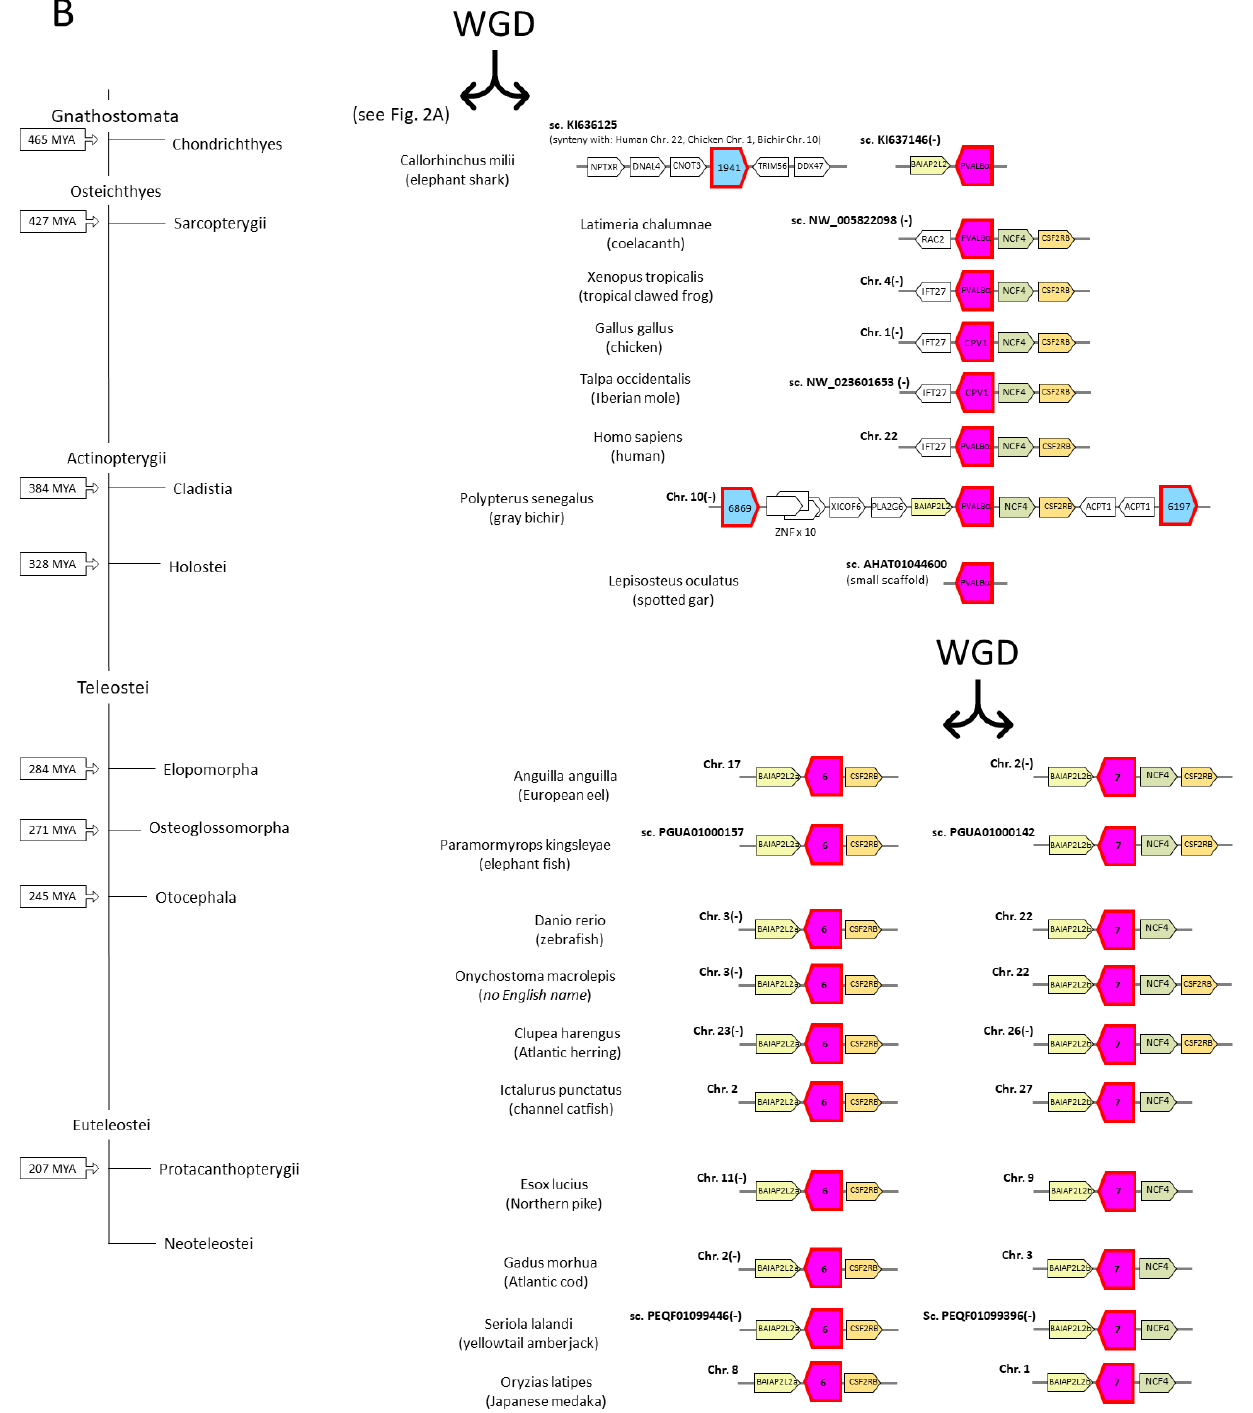
Figure 2. Parvalbumin genes situate in ohnologous regions derived from whole genome duplications (WGD), in humans located on Chr. 7 (( A ); first page) and Chr. 22 (( B ); second page)), and are rather well but not perfectly conserved throughout jawed vertebrates. The parvalbumin genes are indicated with red-lined boxes, which are colored magenta for α -parvalbumins, green for oncomodulins, and different kinds of blue for pvalb10, teleost pvalb5, and teleost pvalb1 ‐ to ‐ 4. Neighboring non ‐ parvalbumin genes are indicated by lower boxes with their name abbreviations inside. For the full names of the parvalbumin genes and their encoded sequences see Supplementary File S1. Box with dashed line, probable pseudogene; sc., scaffold. At the left, the evolution of relevant species clades is shown folowing [77] and [79]; MYA, million years ago. The genomic information was de ‐ rived from either the following Ensembl datasets: Elephant shark, Callorhinchus_milii ‐ 6.1.3;